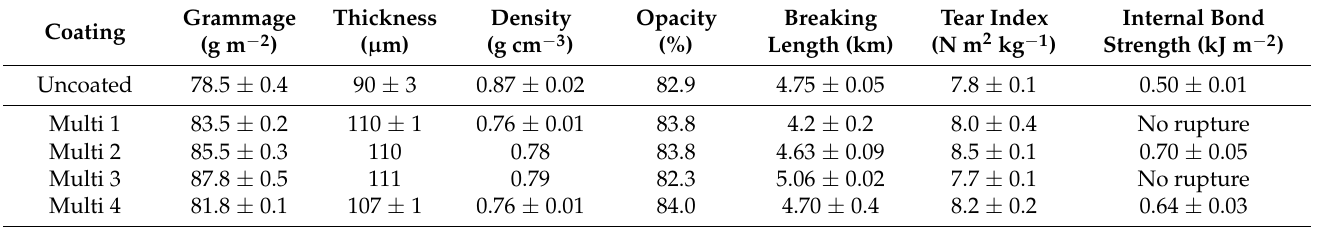
Table 6. Weight, dimensional, optical, and mechanical properties of the sheets coated with multi- purpose formulations. The amplitude of the intervals equals twice the standard